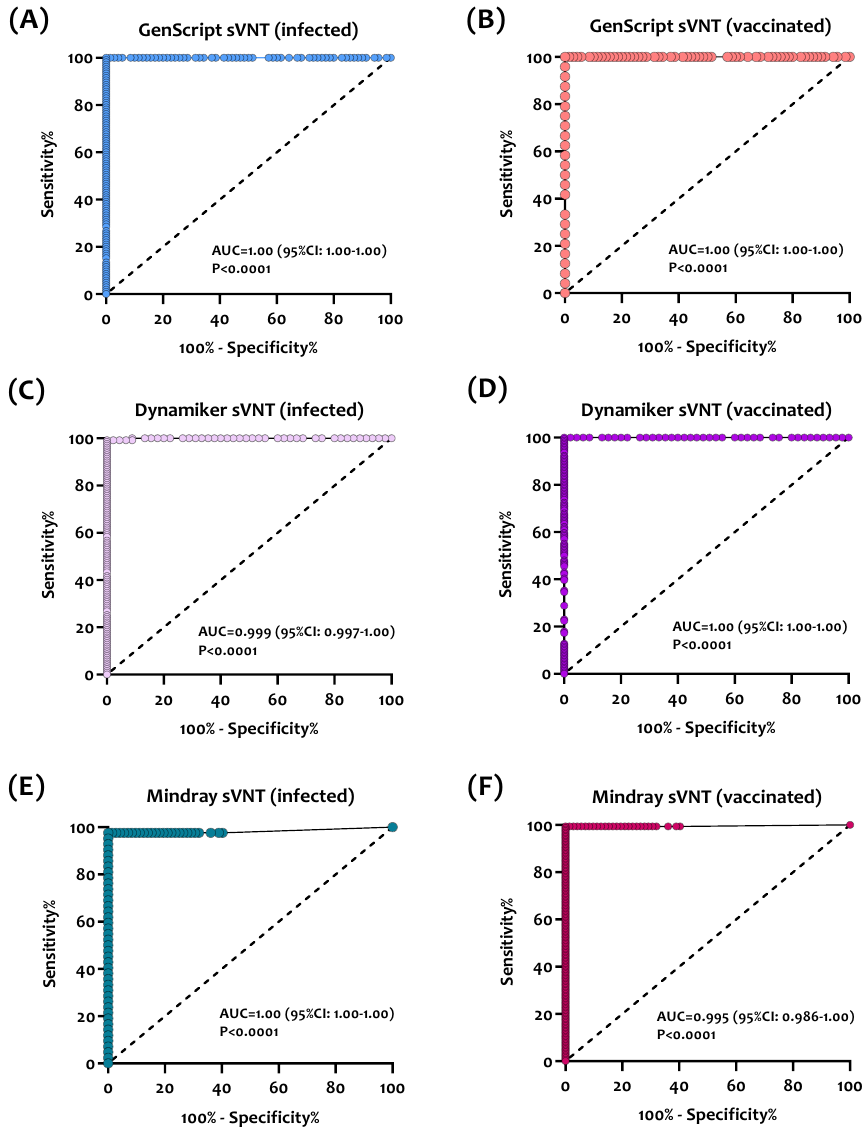
Figure 5. Empirical receiving operating characteristic (ROC) curve analysis for estimating optimal thresholds for sVNT assays targeting nAbs against SARS-CoV-2. ( A ) GenScript sVNT ROC curve in SARS-CoV-2 infected patients (n = 105). ( B ) GenScript sVNT ROC curve in COVID-19 vaccinated individuals (n = 24). ( C ) Dynamiker sVNT ROC curve in SARS-CoV-2 infected patients (n = 127). ( D ) Dynamiker sVNT ROC curve in COVID-19 vaccinated individuals (n = 156). ( E ) Mindray sVNT ROC curve in SARS-CoV-2 infected patients (n = 52). ( F ) Mindray sVNT ROC curve in COVID-19 vaccinated individuals (n = 155). The sensitivity and specificity values correspond to the plotted points which were used to estimate the area under the curve (AUC) and p -value for each